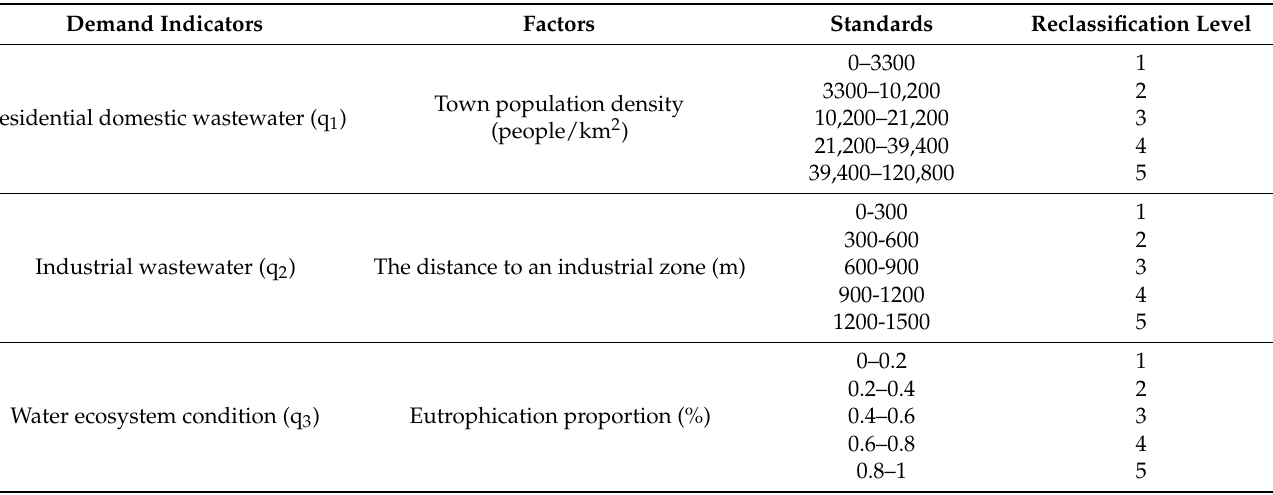
Table 3. The standards of demand